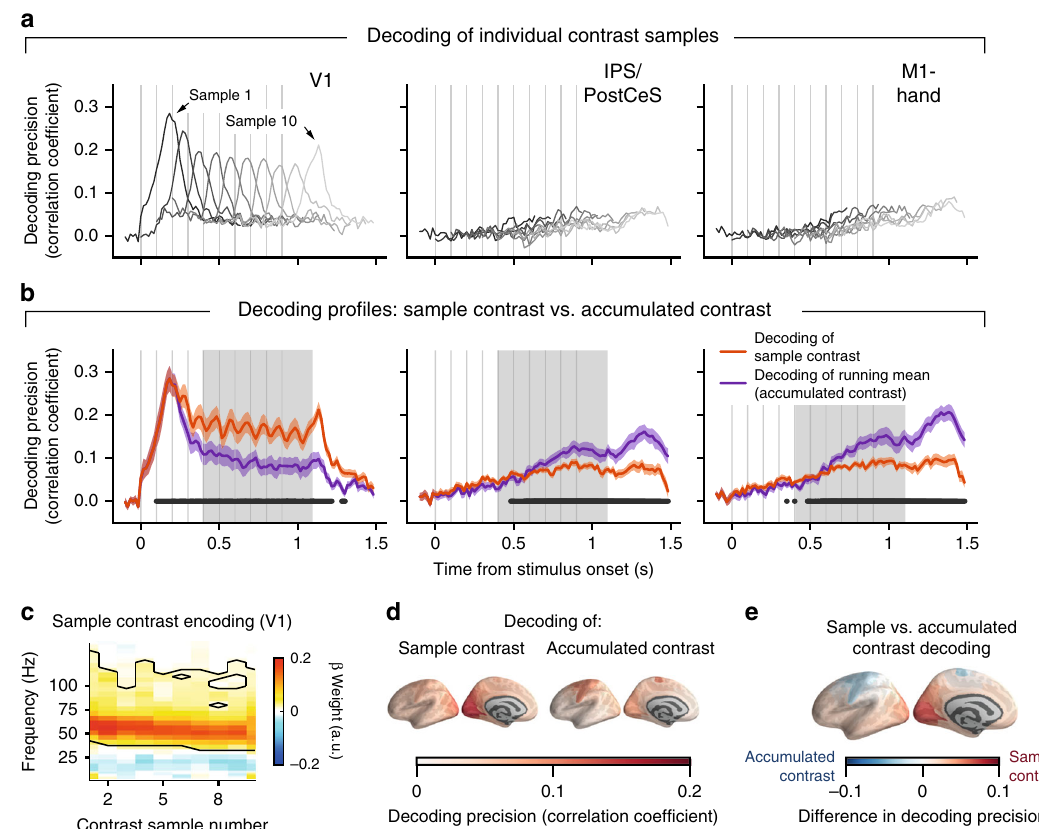
Fig. 3 Decoding of sample contrast and accumulated contrast across cortex. a Time courses of frequency-based (range: 1 – 145 Hz; V1: averaged across hemispheres, IPS/PostCeS/M1-hand: lateralized power values) decoding of single-trial contrast values, separately for each sample position, from V1 (left), IPS/PostCeS (middle) and M1-hand (right) power responses. Decoding precision is expressed as cross-validated Pearson correlation coef fi cient between decoded and presented contrast (see “ Methods ” ). Data are represented as mean ( n = 15 subjects, lines). b Decoding of sample contrast and of running mean of contrast. Orange lines, convex hull across decoding peaks for individual samples in panel a . Magenta lines, convex hull across decoding time courses for the running means of sample contrast values up to sample i ϵ {1, … ,10}. This re fl ects the neural representation of the decision-relevant quantity in the task. Data are represented as mean ( n = 15 subjects, lines) and ±SEM (shaded areas). Horizonal bar: p < 0.05 (cluster-based permutation test of decoding of sample contrast vs. decoding of accumulated contrast). c Encoding of individual contrast samples as a function of frequency. Data are represented as mean beta weights ( n = 15 subjects, color code). Black contour, p < 0.05 (cluster-based, two-sided permutation test). d Group average decoding precision ( n = 15 subjects, convex hull averaged across gray shaded areas in B) for all ROIs: single-contrast samples (left), accumulated contrast (center), and their difference (right). Source data are provided as a Source Data fi